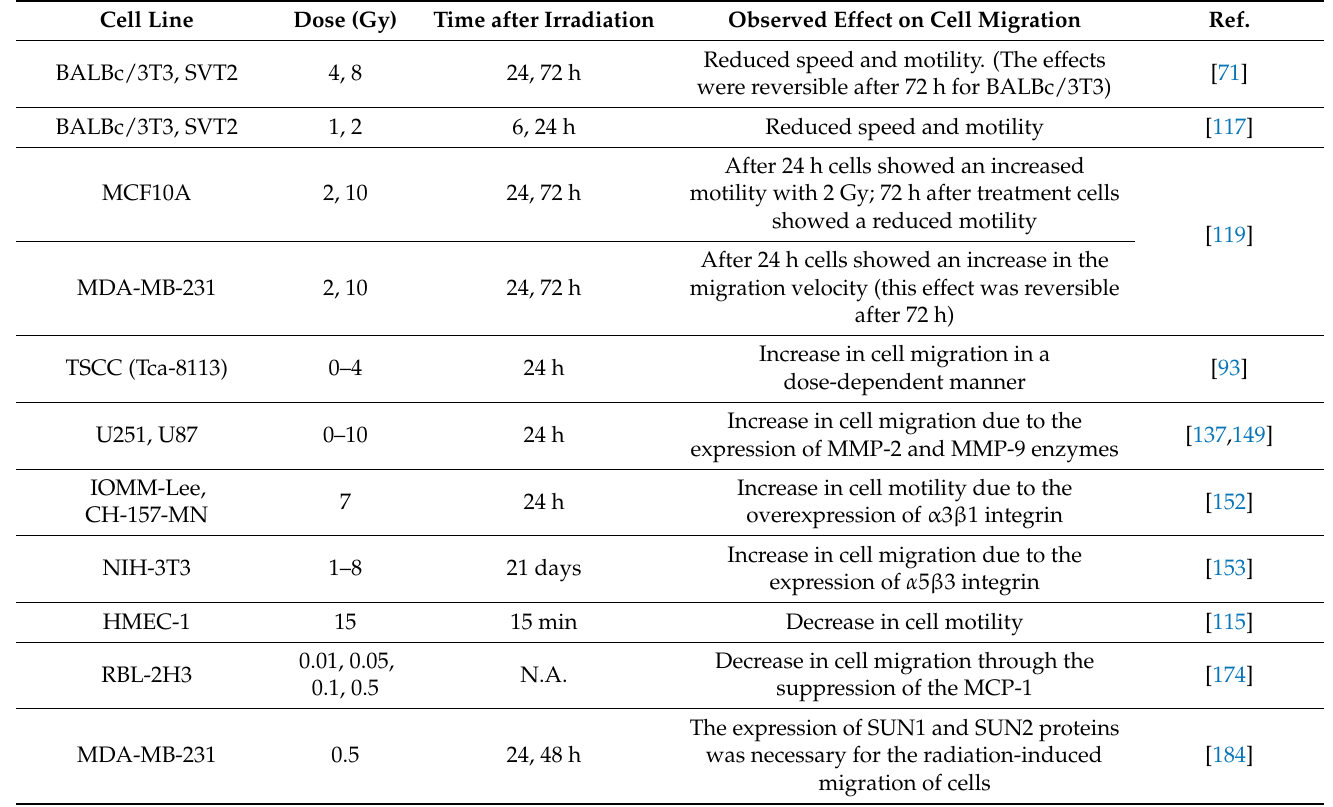
Table 3. Effects of radiation on cell